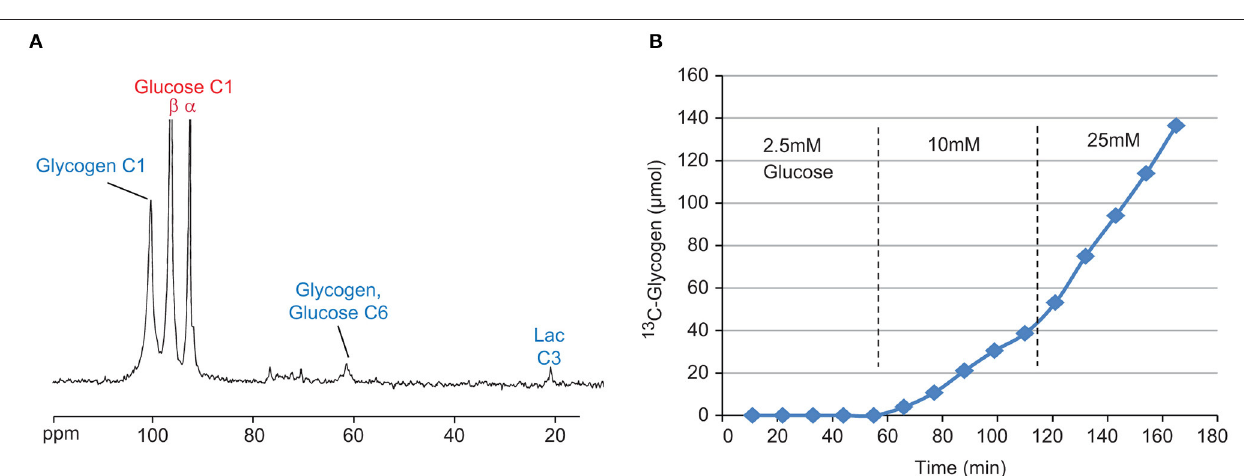
FIGURE 3 | Sample 13 C NMR spectrum (A) of perfused liver after 50 min with 20 mM [1- 13 C] Glucose. Visible signals include [1- 13 C] Glycogen (100.6 ppm), [1- 13 C] Glucose ( β -anomer 96.8 ppm, α -anomer 93 ppm), [6- 13 C] Glucose (61.6 ppm) from indirect glycogen synthesis, and [3- 13 C] Lactate (21.1 ppm) from glycolysis.